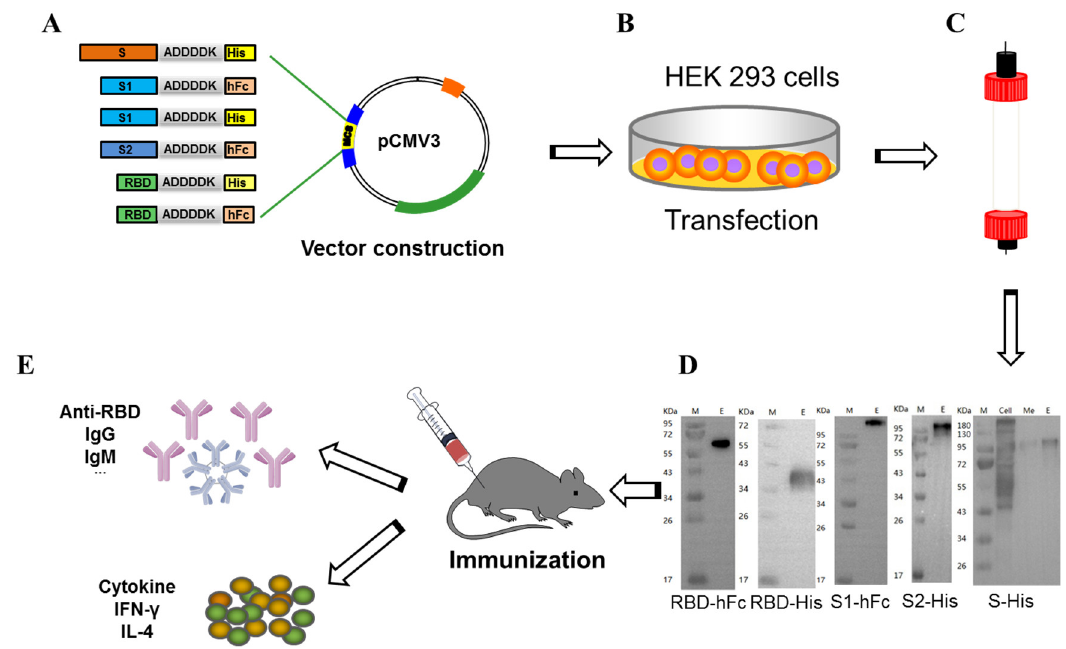
Figure 1. Schematic diagram of recombinant subunit protein vaccines and experimental design. Expression vectors containing either S-His, S1-His, S1-hFc, S2-His, plus an RBD-His or RBD-hFc fusion protein ( A ) was transfected into HEK293 cells ( B ). Recombinant fusion proteins were purified by column chromatography ( C ) and resolved and visualized by SDS-PAGE ( D ) (Lane M: protein marker; Lane E: elution target protein). ( E ) Schematic diagram of murine immunization with S-His, S1-His, S1-hFc, S2-His, RBD-His and RBD-hFc vaccines. Female Balb/c mice were immunized twice with S-His, S1-His, S1-hFc, S2-His, RBD-His and RBD-hFc fusion proteins ( n = 5 per